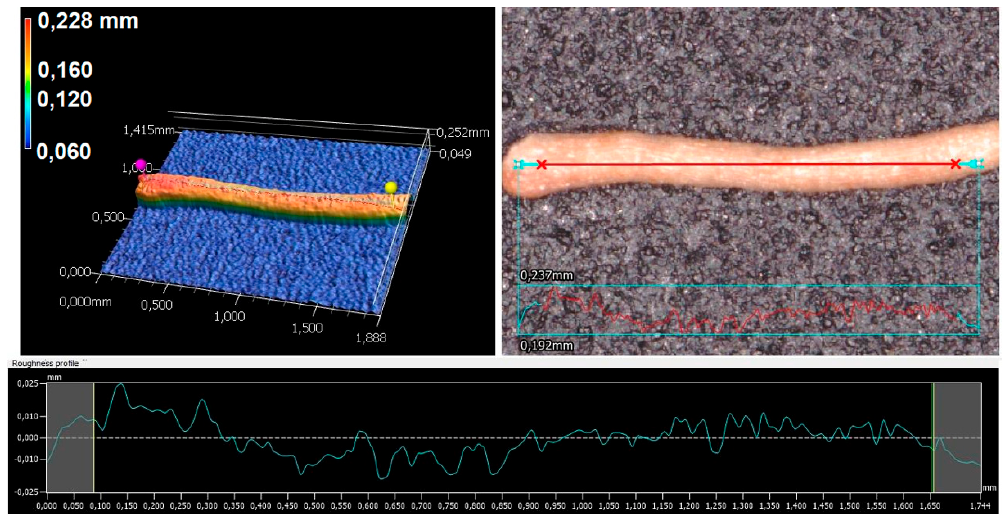
Figure 4. Roughness profile, optical micrograph and 3D height map of a single CCF.